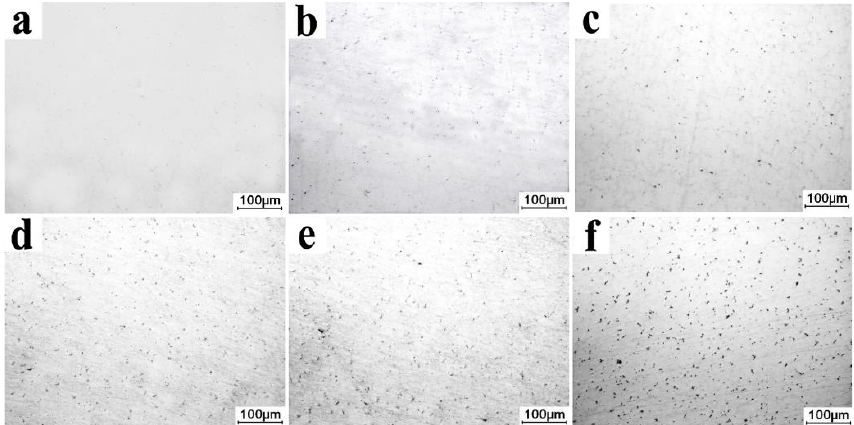
Figure 12. Variation of grain size of Graphite/AZ91D composites with different holding times.